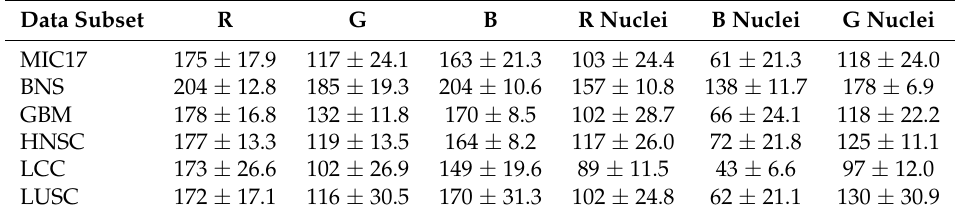
Table 3. Colour statistics extracted from the used datasets and subsets. From the left: average and standard deviation for the whole image, red (R), green (G), blue (B) and average and standard deviation for the nuclei only, R nuclei, G nuclei and B